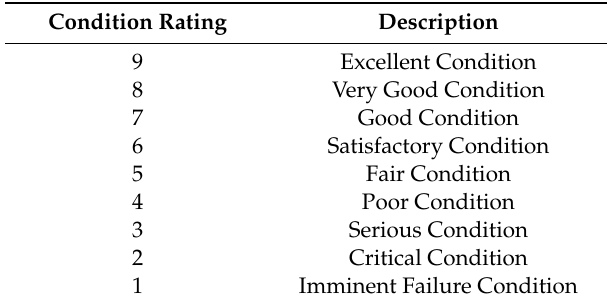
Table 1. National Bridge Inspection Standard (NBIS) bridge condition